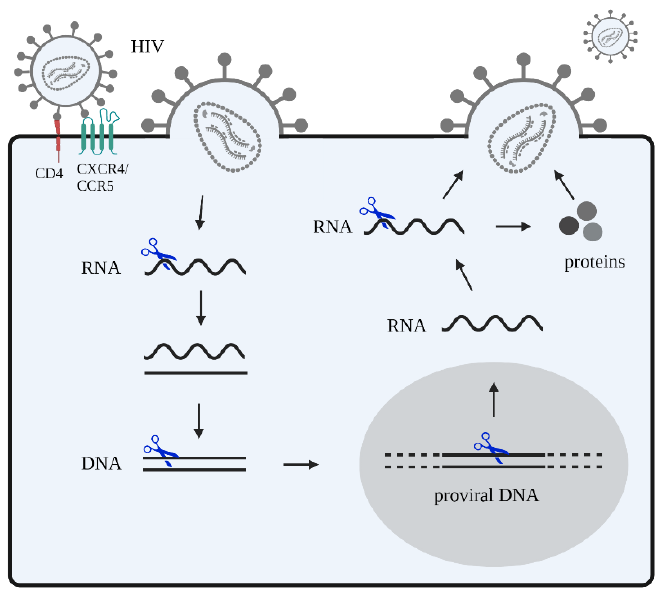
Figure 2. HIV attack with CRISPR-Cas-based inhibitors. HIV recognizes and binds to the host receptors CXCR4 and/or CCR5 in CD4+ T cells, and fuses with the cellular membrane. Subsequently, viral RNA is released into the cytoplasm. This viral RNA is reverse transcribed into DNA that integrates into the host genome. In the nucleus, this proviral DNA is transcribed and transported to the cytoplasm where it is translated. Viral proteins are expressed and are then packaged as well as assembled into a viral core structure that buds from infected cells and is released as new virions. CRISPR-Cas gene editing strategies (blue scissors) can be designed to target viral DNA and RNA. Other potential targets include the host DNA encoding for proteins that facilitate steps of the HIV replication cycle, such as the main CD4 receptor and co-receptors (CCR5 and CXCR4).